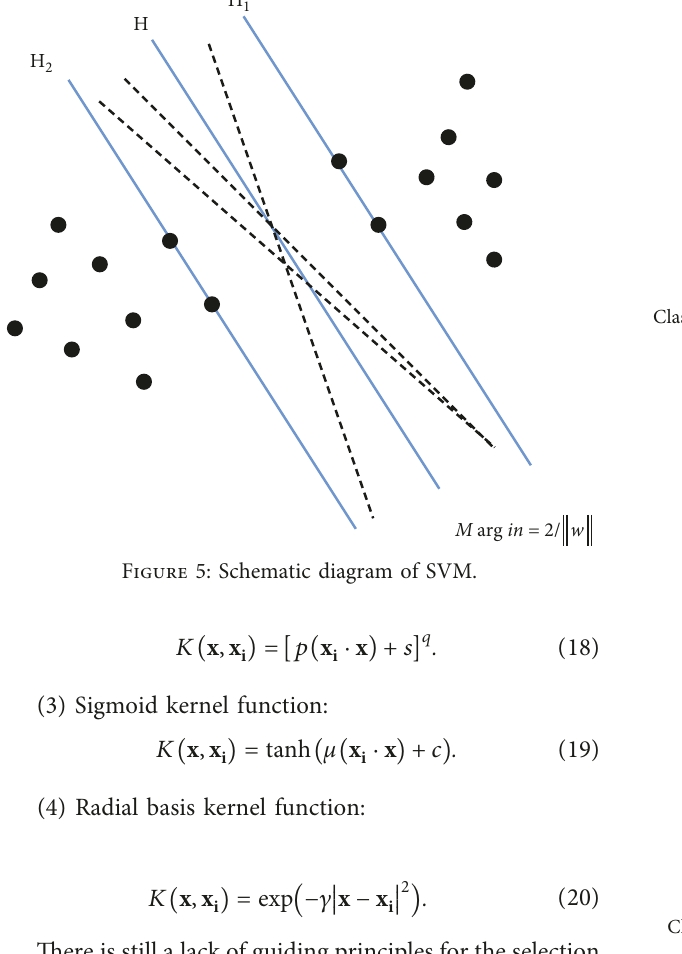
Figure 5: Schematic diagram of